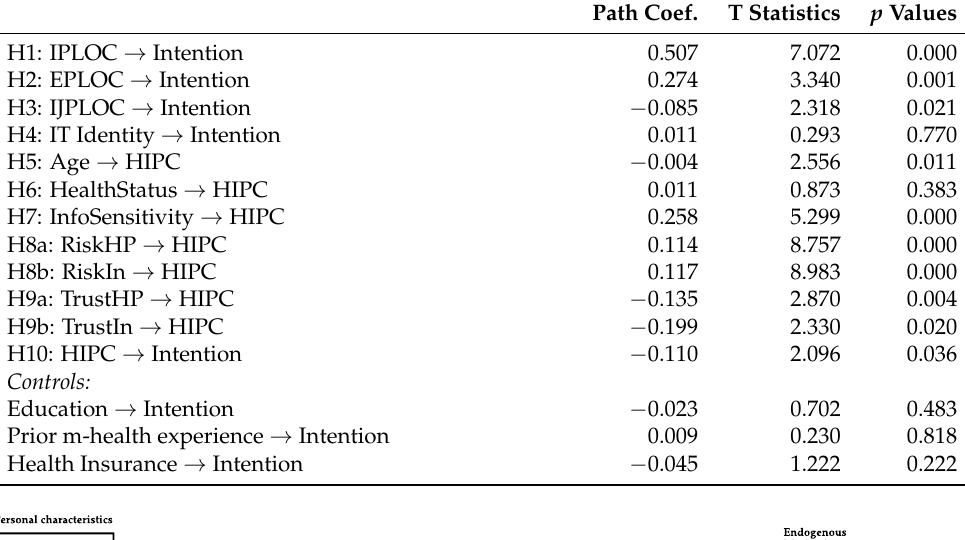
Path Coef. T Statistics p Values